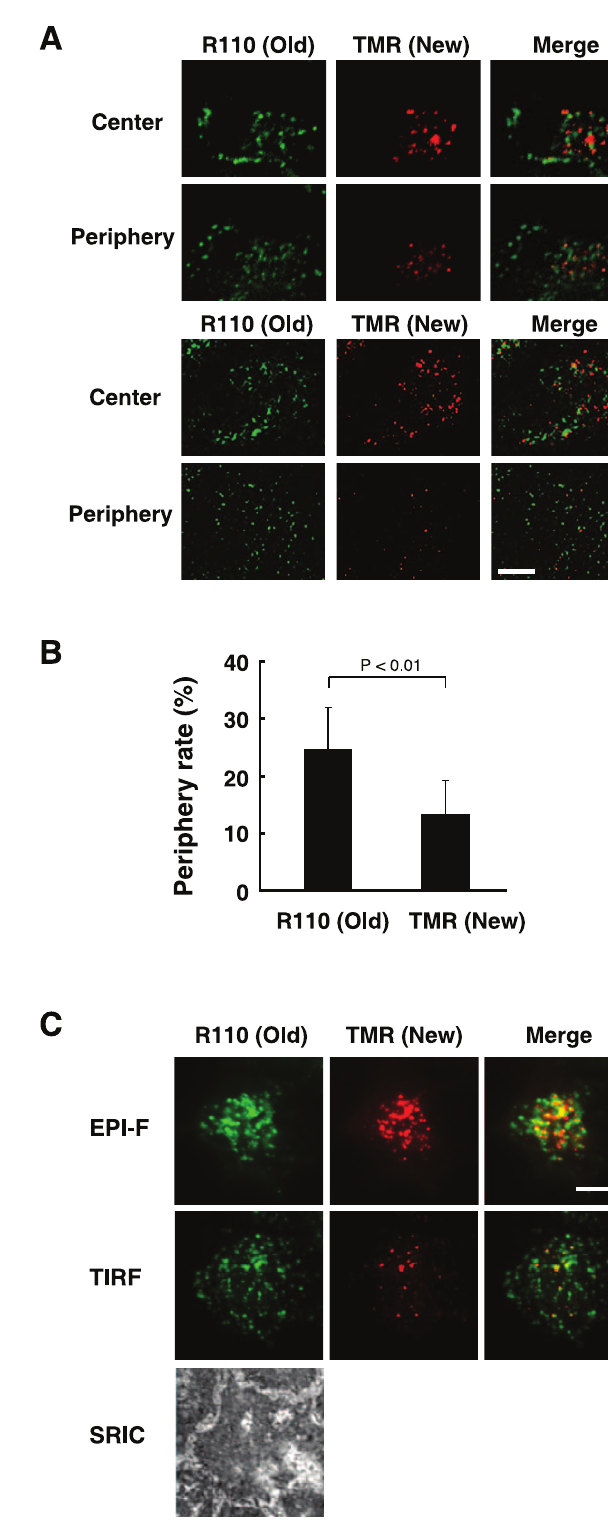
Figure 3. Secretory granules containing newly synthesized insulin are located at the interior of the cell. A, MIN6/insulin-HT cells were incubated with 100 nM HT-R110 probe for 16 hours. The cells were then incubated in modified Krebs-Ringer buffer lacking dyes for 1 hour, and further incubated with 5 m M HT-TMR in buffer for 30 minutes. After removal of excess probe, the cells were fixed and fluorescent signals of R110 and TMR were observed by confocal microscopy in